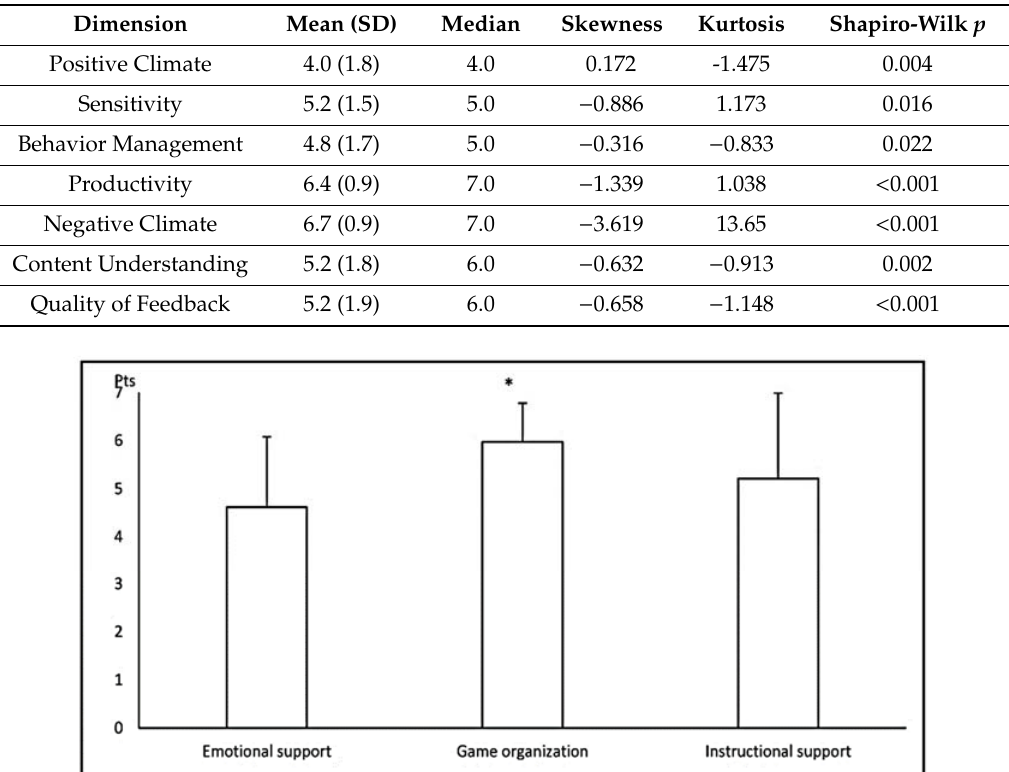
Table 4. Results of factor analysis after Varimax rotation (two ‐ factor solution): values represent factor loadings for the assessments.